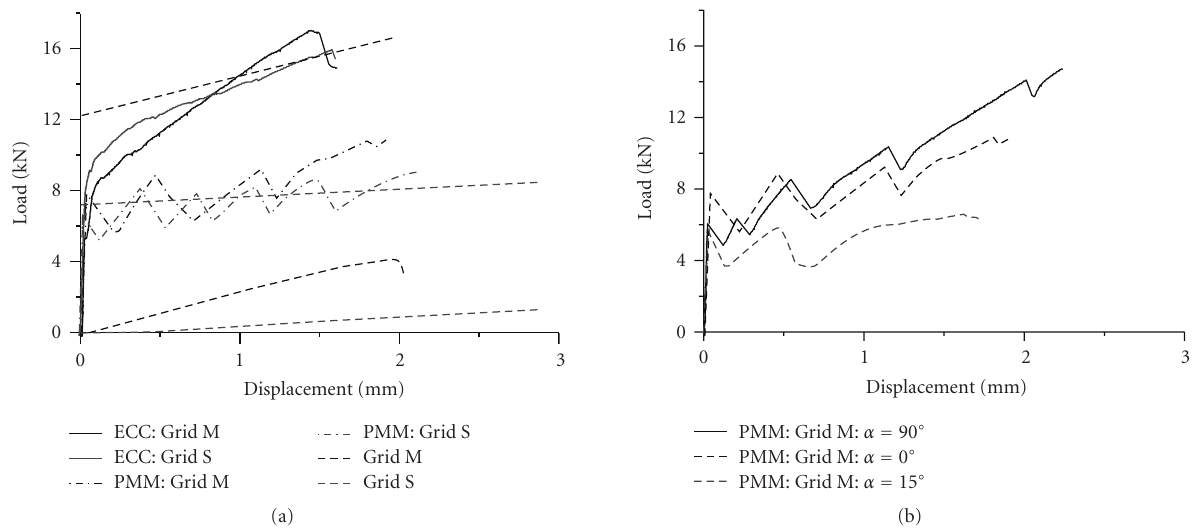
Figure 6: (a) All dogbone specimens with grid S and M placed in longitudinal (0 ◦ ) direction. (b) E ff ect of grid orientation (transverse (90 ◦ ), longitudinal (0 ◦ ) and rotated in 15 ◦ ).